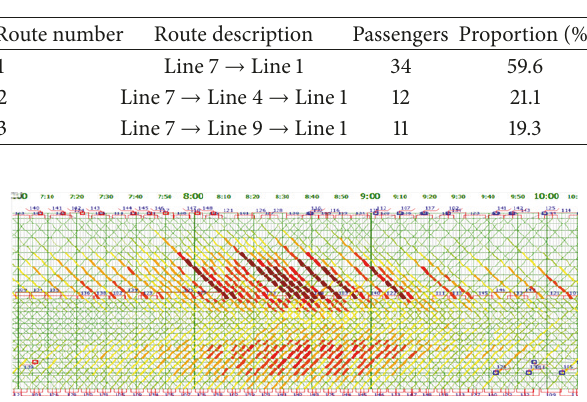
Table 8: Route choices deduced from estimated boarding plans.